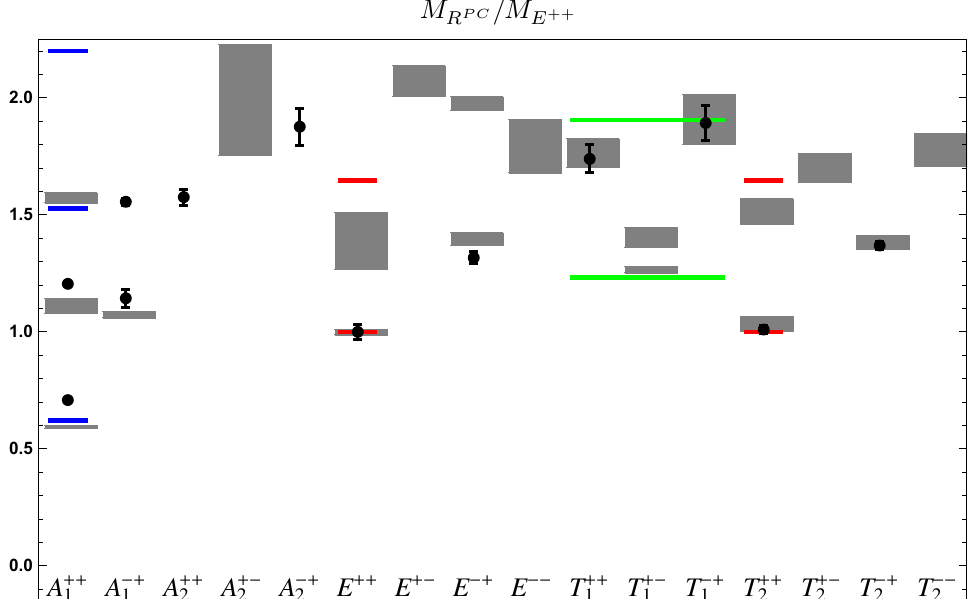
Figure 5 . Masses of glueballs from lattice results compared to the three towers of universal results in this paper. Lattice results for SU( N ), extrapolated to N + are taken from (cid:12)gure 20 ! 1 in [8], are labelled left-to-right A ++ ; A + (cid:0) ; , the discrete lattice quantum numbers R PC , are 1 1 (cid:1) (cid:1) (cid:1) represented by the shaded grey rectangles, and are normalised with respect to the E ++ state as M =M . Lattice results for Sp(4) are taken from [11], in which case all states have C = +, E ++ R PC and are represented by the black dots (with error bars). Notice that we interchanged the T 1 and T 2 labels, to be consistent with the conventions in [8]. The three universal towers are: the (cid:13)uctuations of the scalar (cid:31) (blue), the tensors (red), and the gravi-photon (green). We do not commit to a choice of which tower of spin-1 states in the lattice results should be identi(cid:12)ed with the gravi-photon. We normalise the supergravity masses to the mass of the lightest tensor, so that all three data sets agree on the lightest E ++